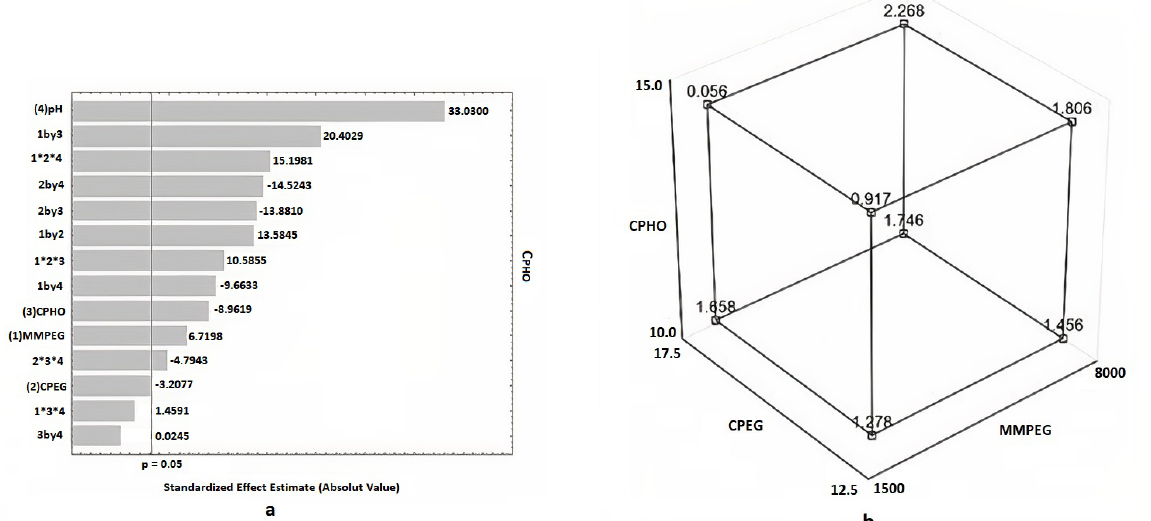
Figure 1. a - Effects of the independent variables (M PEG , C PEG , C PHO and pH) on the partition coefficient (K) of fibrinolytic protease extracted by PEG/ phosphate ATPS according to the preliminary 2 4 full factorial design. b - Cubic plot of the effects of M PEG and C PEG and C PHO on the purification factor (FP) in the PEG phase ATPS. M PEG (1) = PEG molar mass; C PEG (2) = PEG concentration; C PHO (3) = phosphate concentration; pH (4) = potential of